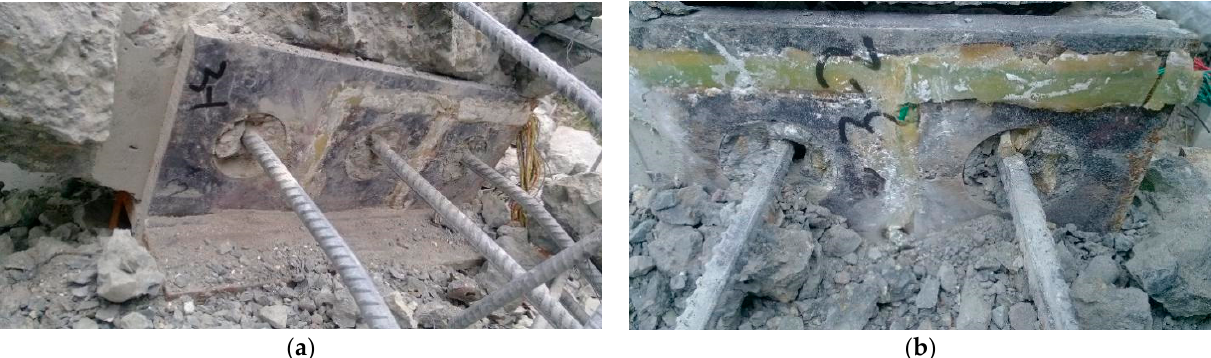
Figure 26. Concrete dowel failures of the BH3 specimen after the test: ( a ) Concrete dowel failures of the BH3-1 specimen; ( b ) Concrete dowel failures of the BH3-2 specimen.